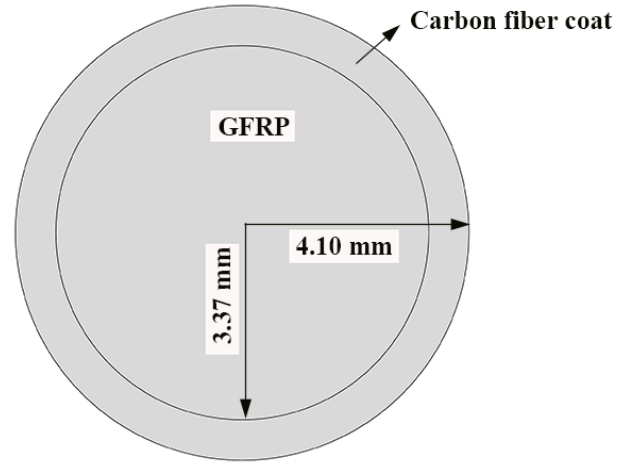
Figure 3. The finite element model of the diffusion of water into the HFRP bars.